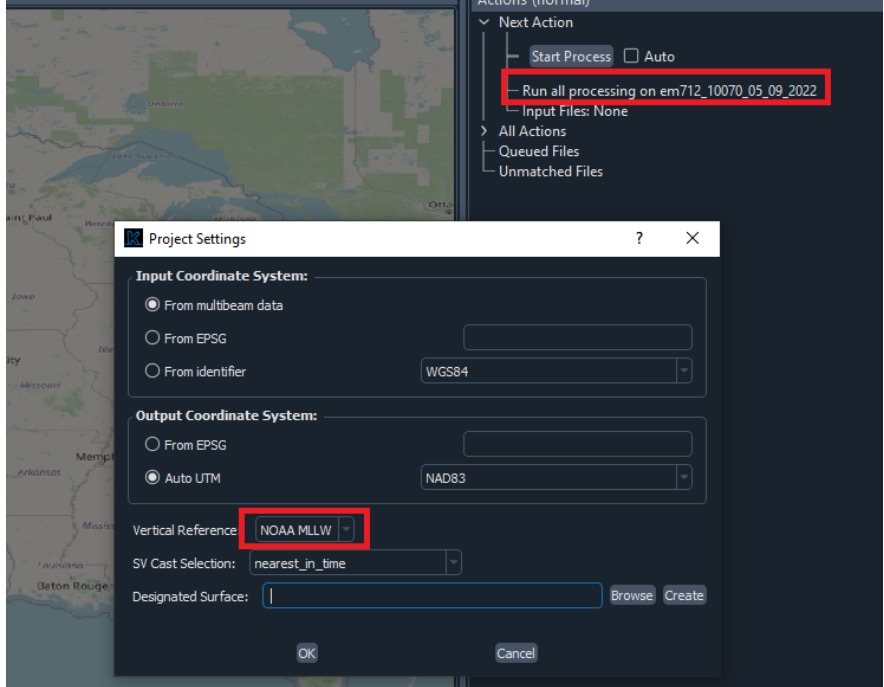
Figure 4. Project settings with desired vertical reference and the “Run all processing” action that is spawned as a result.